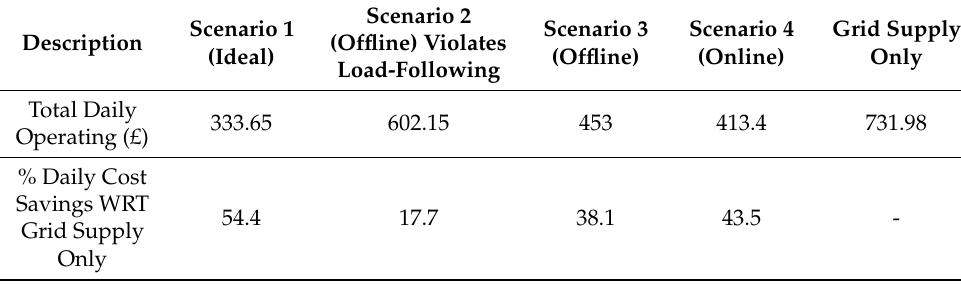
Table 6. Total daily operating cost and % saving for all